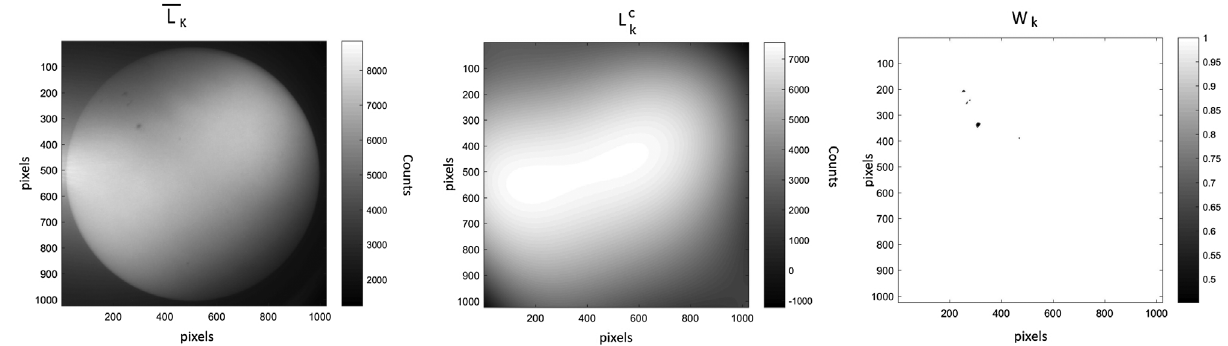
Fig. 9. Sample of a single image L j ( left panel ), and corresponding L c j ( central panel ) and W j ð t Þ ( right panel ) computed for the MOTH